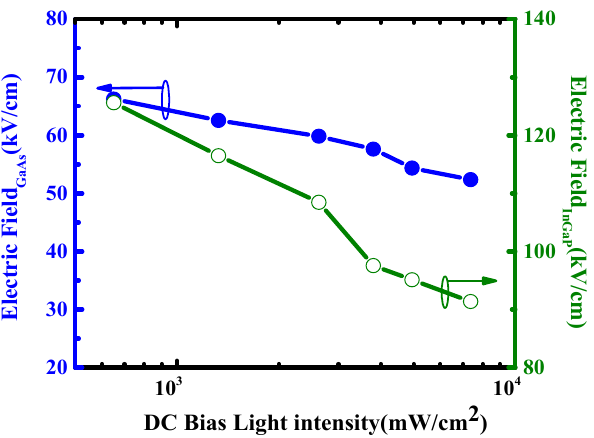
Figure 8. The internal electric field (F pn ) of InGaP (open circle) and GaAs (solid circle) versus the CW light intensity (I OB ) at 300 K.